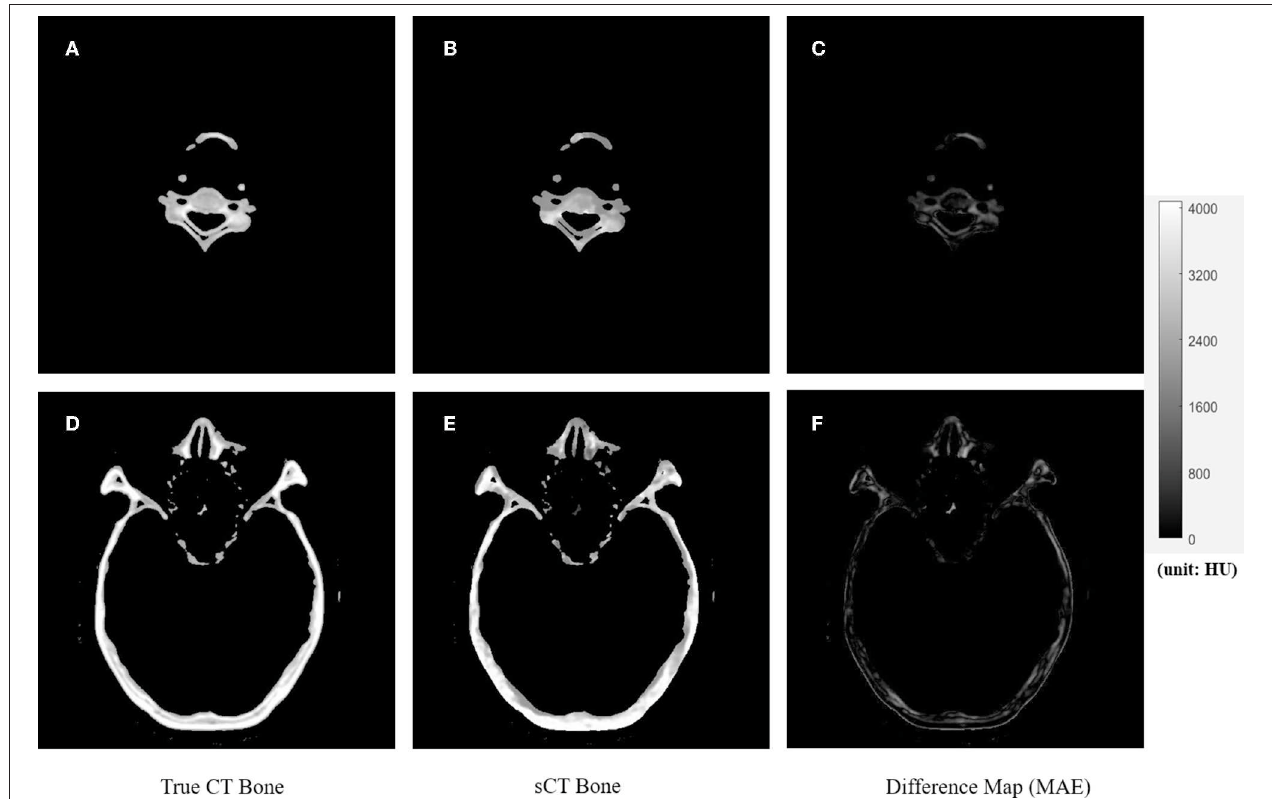
FIGURE 4 | The comparison of true CT and synthetic CT for bone. The first column is true CT images. The second column is the synthetic CT images. The third column is the difference maps. (A–C) Showed bone in the neck region. (D–F) Showed bone in the head and nasal region. Gray bar indicated the mapping from CT number to gray scale in the difference